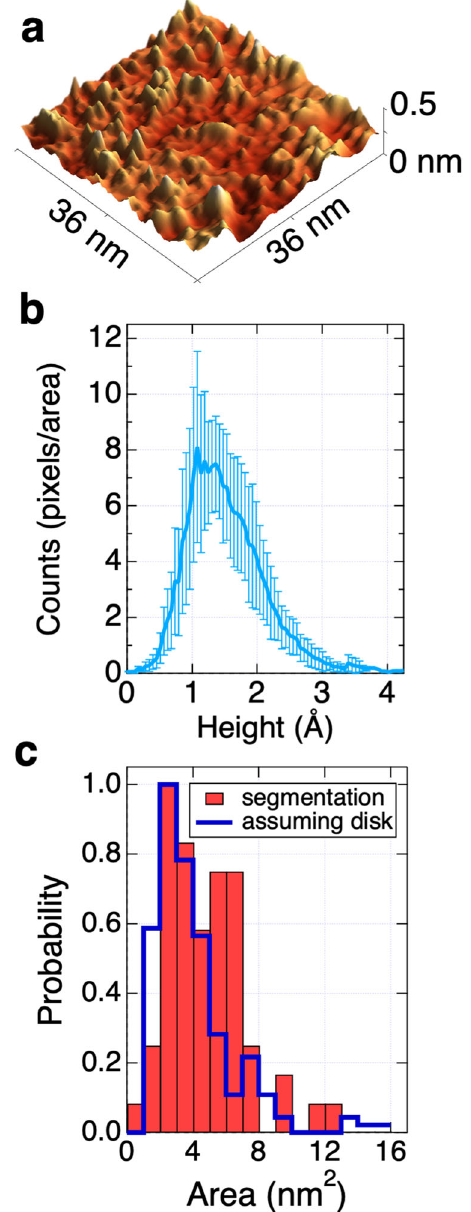
Fig. 2 Geometric structure of the oxide particles. a 3D topography image showing the oxide particles present after 7 L of oxygen exposure along with ( b ) their height distribution. The area distribution of these particles is summarized ( c ) and was determined two different ways, (i) via gray-scale segmentation (see supplemen- tary information) and (ii) line scans combined with the assumption that the particles are disks ( A ¼ π r 2 ), which was used to translate radius into area distributions. The topography image was taken at V bias = 2.0 V, I t = 0.1 nA. The error bars in ( b ) were calculated using standard